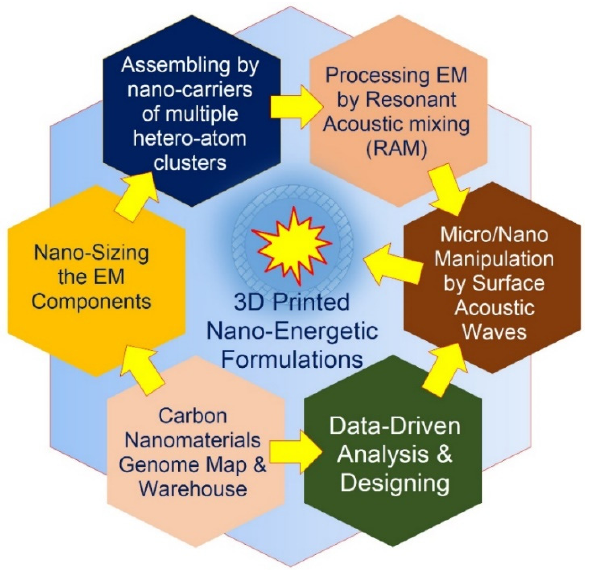
Figure 14. Modification of the technological chain of the transformative energetic materials' multi- stage synthesis.